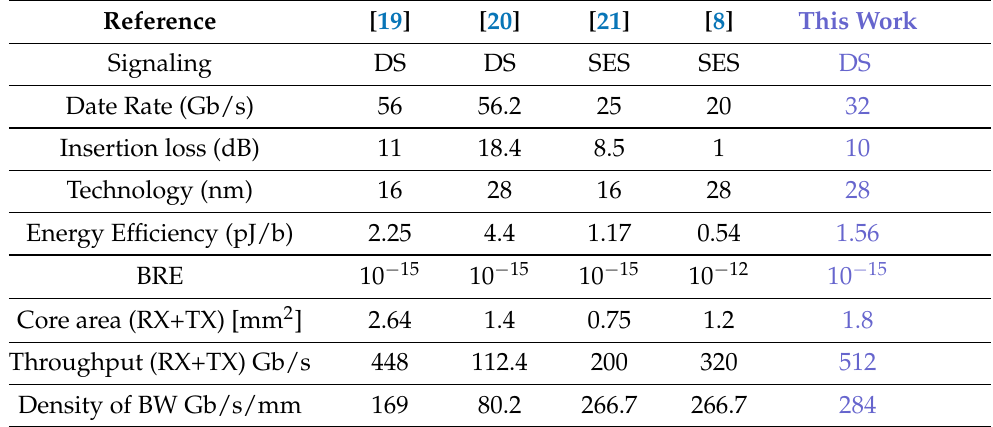
Table 4. Performance